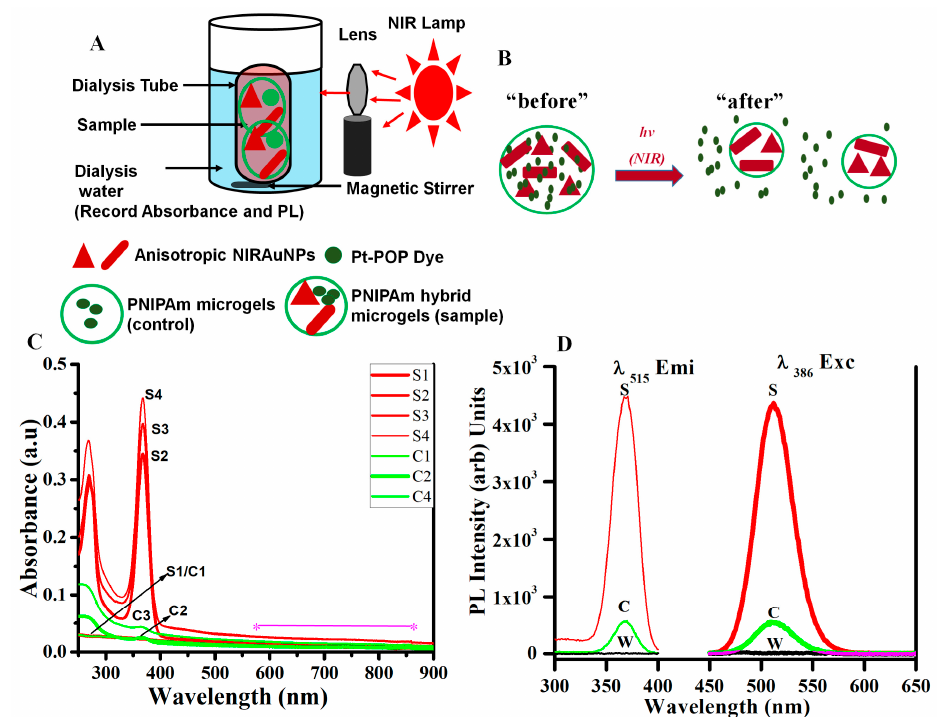
Figure 9. Demonstration of the release of a dye molecule from hybrid PNIPAm- co -allylamine microgels containing NIR-absorbing AuNM (hybrid microgels) on irradiation with NIR light source. ( A ) Schematic illustration of dye-release studies from the hybrid microgels containing NIRAuNMs and Pt-pop dye. ( B ) Schematics of dye release “before” and “after” irradiation with the NIR light source. ( C ) Changes in absorption spectra at 0, 15, 30, and 45 min (1,2, 3, and 4) of irradiation for control and hybrid microgels. ( D ) Photoluminescence spectra of dialysis water at 45 min of irradiation (solid lines: emission spectra and dashed lines: excitation spectra). W–blank water, C–control microgel, and S–hybrid microgel.